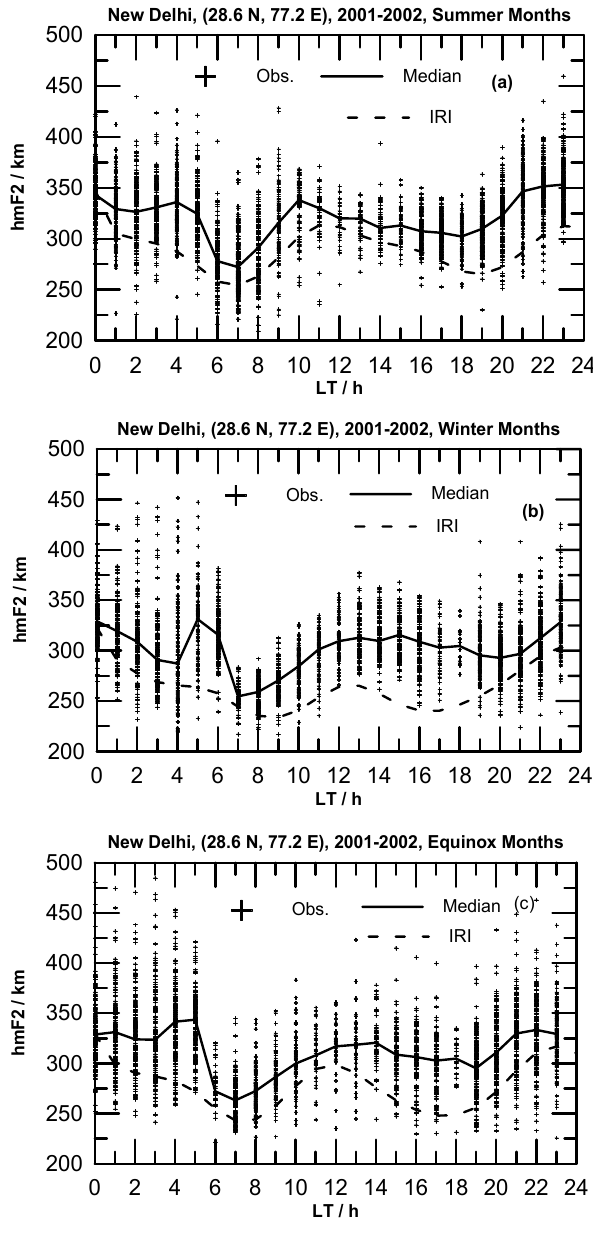
Fig. 2 Fig. 2. A scatter plot showing diurnal variation of the parame- ter hm F2 derived from scaled ionospheric parameters using digital ionosonde over New Delhi, (28.6 ◦ N, 77.2 ◦ E), employing Dudeney (1983) empirical formulation, for (a) summer, (b) winter and (c) equinox. The median values are shown as a solid line. The IRI predicted values are shown as dashed